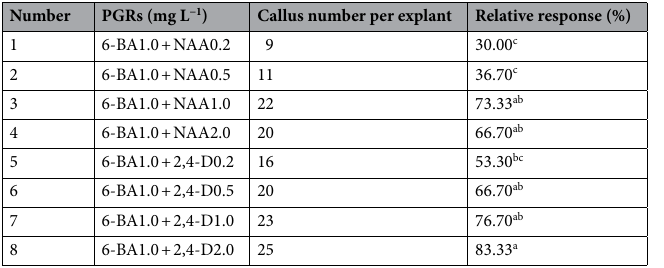
Table 1. Effects of different concentrations and combinations of 6-BA, NAA and 2,4-D on callus frequency from